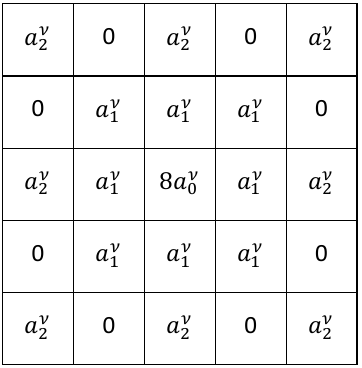
Figure 2. Fractional integral operator.